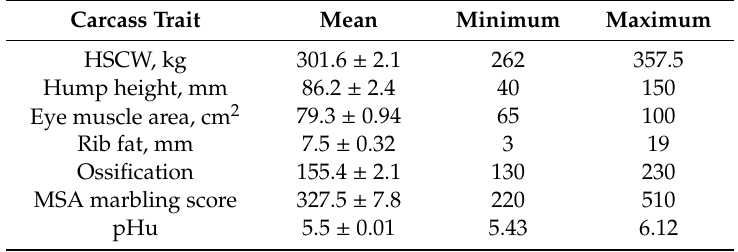
Table 1. Mean ( ± SEM), minimum and maximum carcass characteristics as determined by the Meat Standards Australia (MSA) beef carcass grading